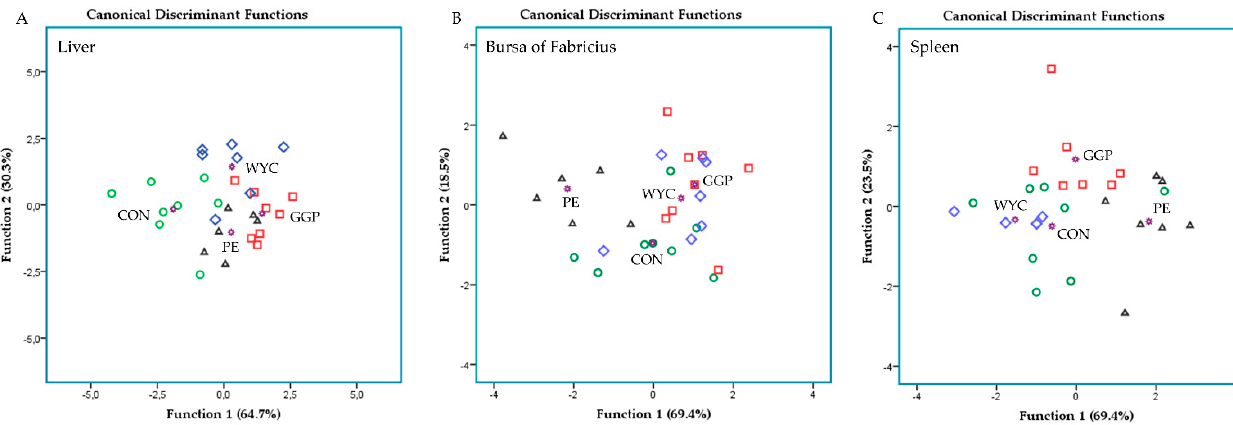
Figure 3. Relative transcript levels (means ± SEM) of immune-related genes in the spleen of 42-day-old broilers. Bars with different letter (a, b) amongst the treatments differ significantly ( p ≤ 0.05), while t represents 0.05 < p -value < 0.10.